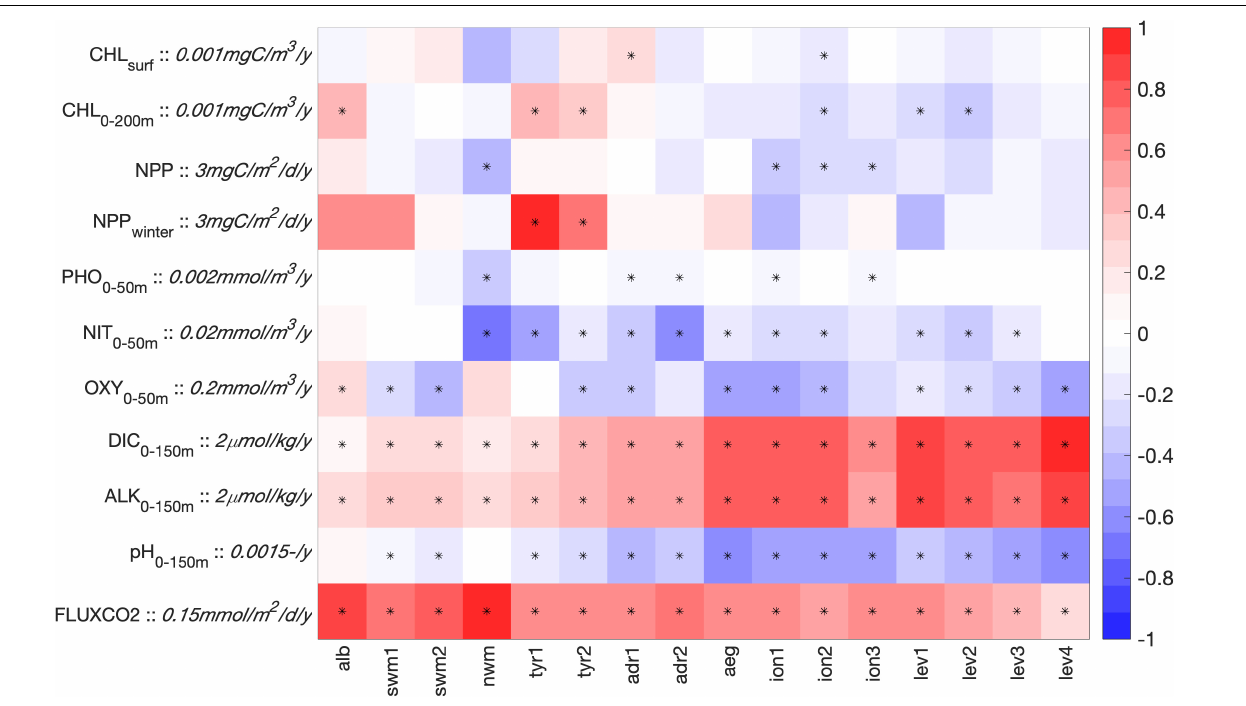
FIGURE 10 | Trend slope values for selected variables in the 16 sub-basins. Color scale range is adapted considering the range of variability or mean values of each variable (scale factor is provided together with the variable unit). The symbol ∗ marks significant trend ( t -test at p -level of